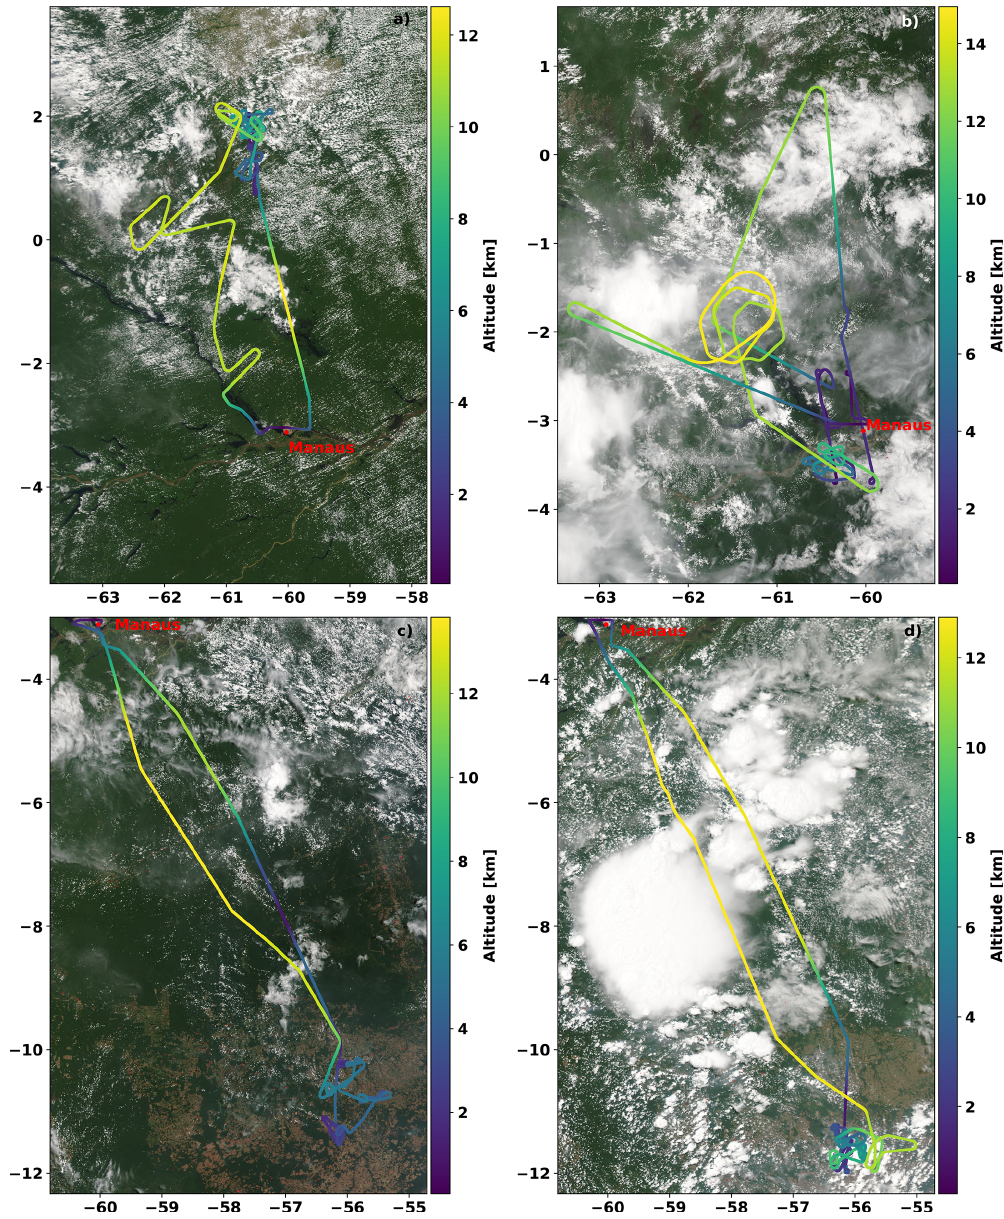
Figure 5. Tracks of the ACRIDICON-CHUVA flights (a) on 11 September 2014, (b) on 16 September 2014 (AC11), (c) on 18 Septem- ber 2014 (AC12), and (d) on 19 September 2014 (AC13). All flights started and ended at the operational base Manaus airport in Brazil (red dot). The colour coding indicates the flight altitude. The MODIS satellite images are from 14:10UTC (11 September 2014), 14:30UTC (16 September 2014), 14:20UTC (18 September 2014), and 17:55UTC (19 September 2014). The images were taken from NASA Worldview (https://worldview.earthdata.nasa.gov/, last access: 16 October